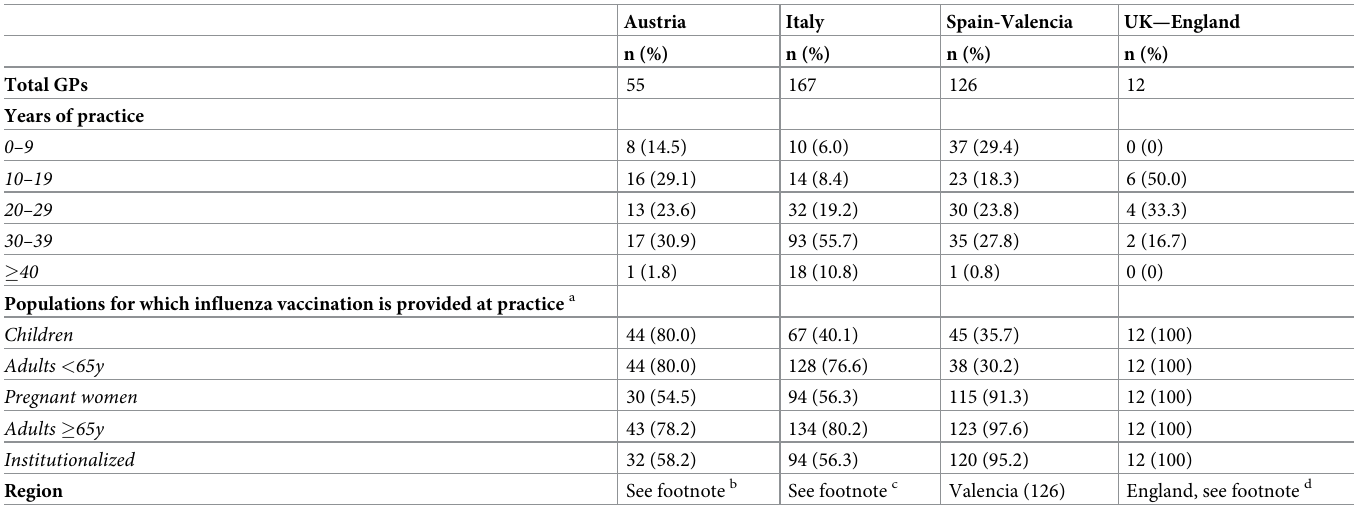
Table 2. Characteristics of GPs participating in the